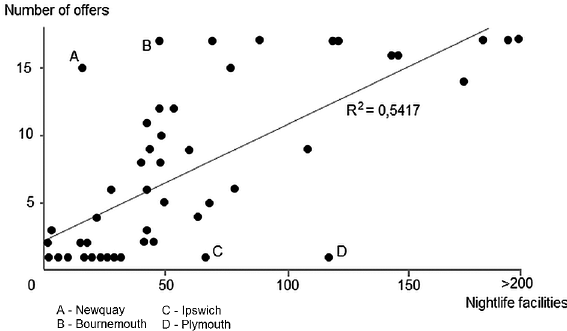
Fig. 4. Correlation between the popularity of British